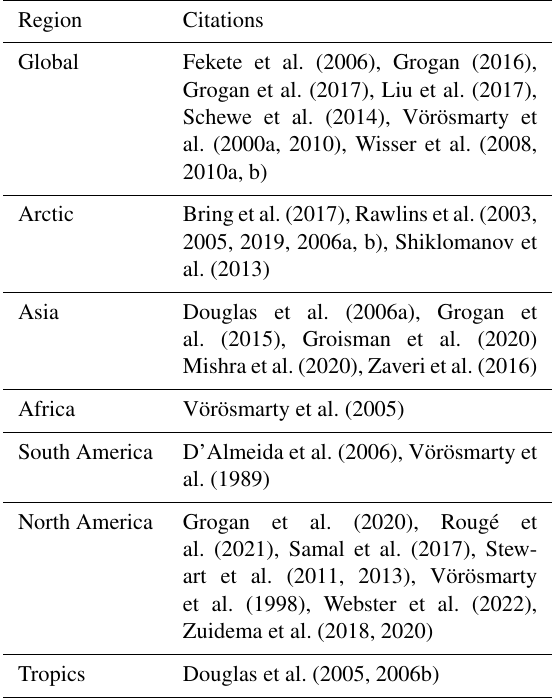
Table A1. Examples of WBM applications over different regions across the